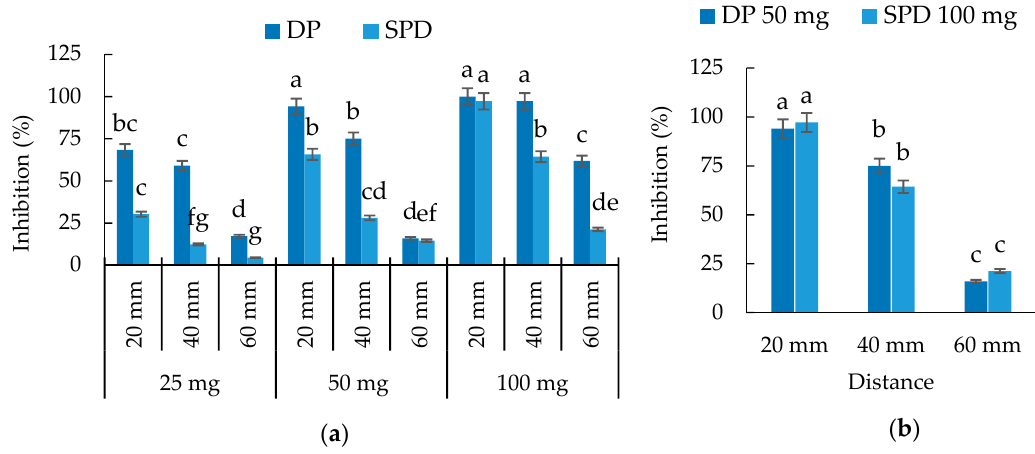
Figure 10. Comparison of the radicles of the S. mukorossi test plants between the DP method and the SPD method. ( a ) Control level of growth (%) with di ff erent amounts of samples with di ff erent distances. ( b ) Comparison of the control level of growth (%) status in DP with 50 mg of crude dry plant sample and SPD with 100 mg of the sample. The data was compared by Tukey’s HSD test (the same alphabet indicates there is no significant di ff erence between two treatments). Values are the average of nine replications ( ± ) standard error.